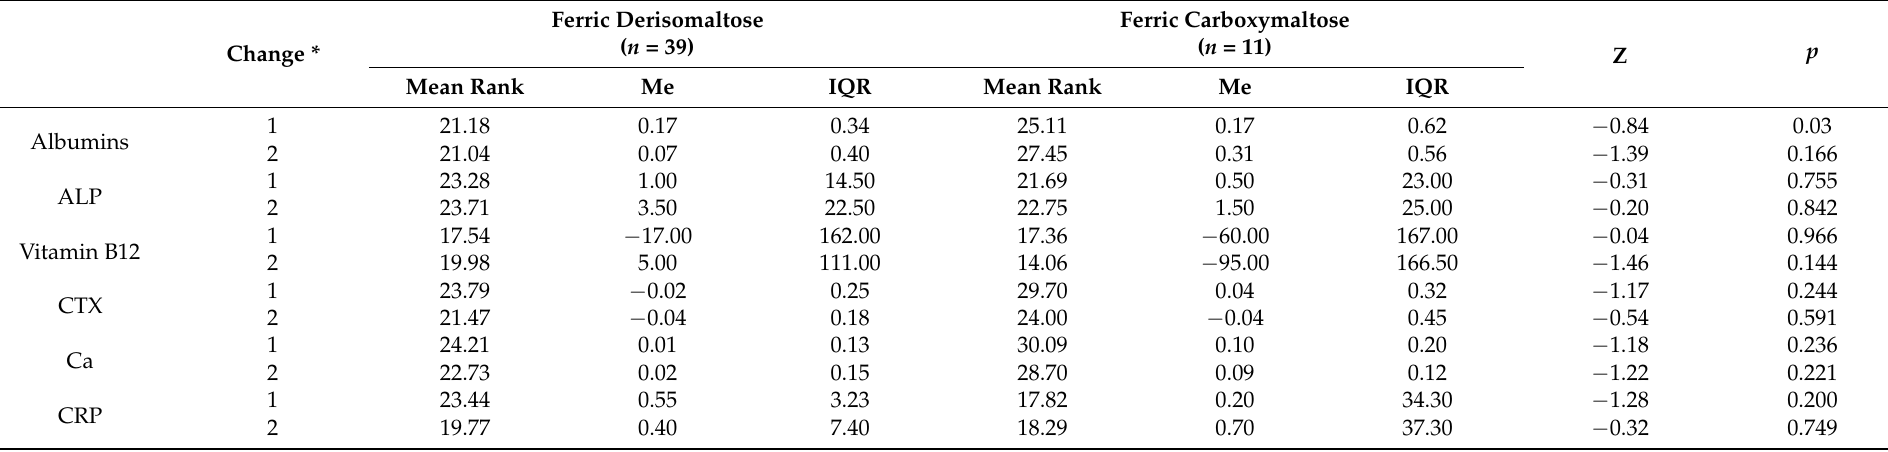
Table 4. Comparison of changes in biological markers in patients receiving ferric derisomaltose and ferric